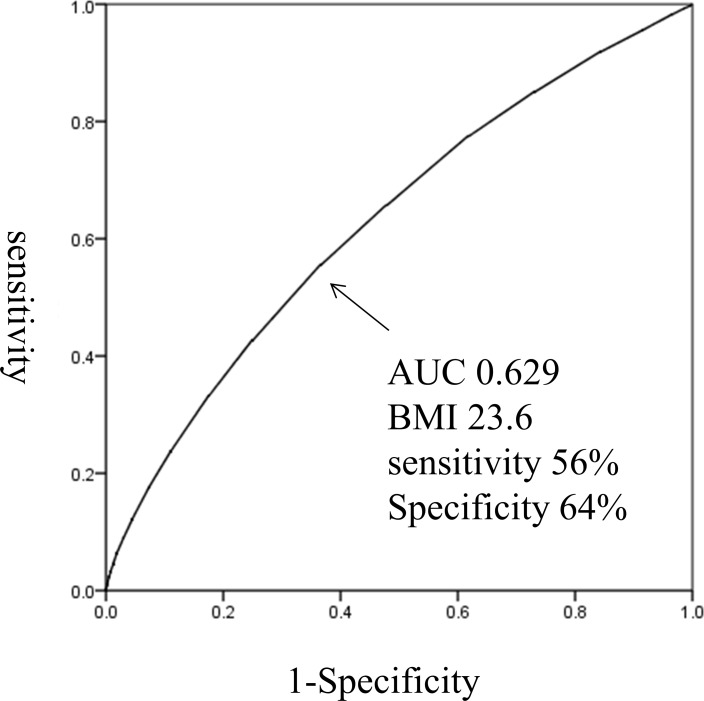
The optimal BMI cut-off for detection of DM in patient in Tottori Prefecture.